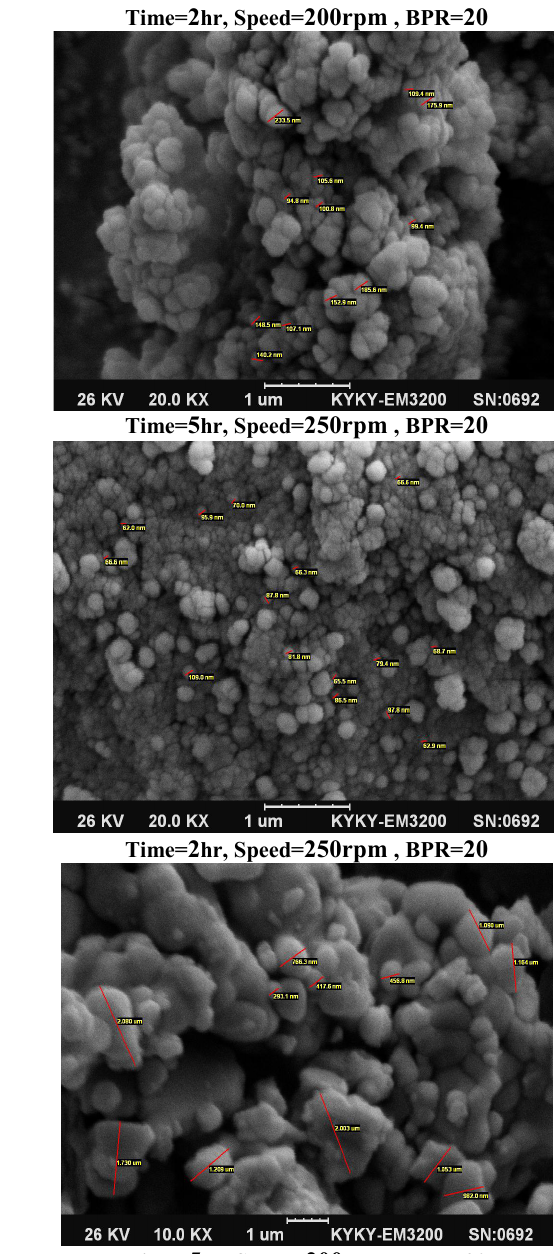
Fig. 2. SEM images of PbO